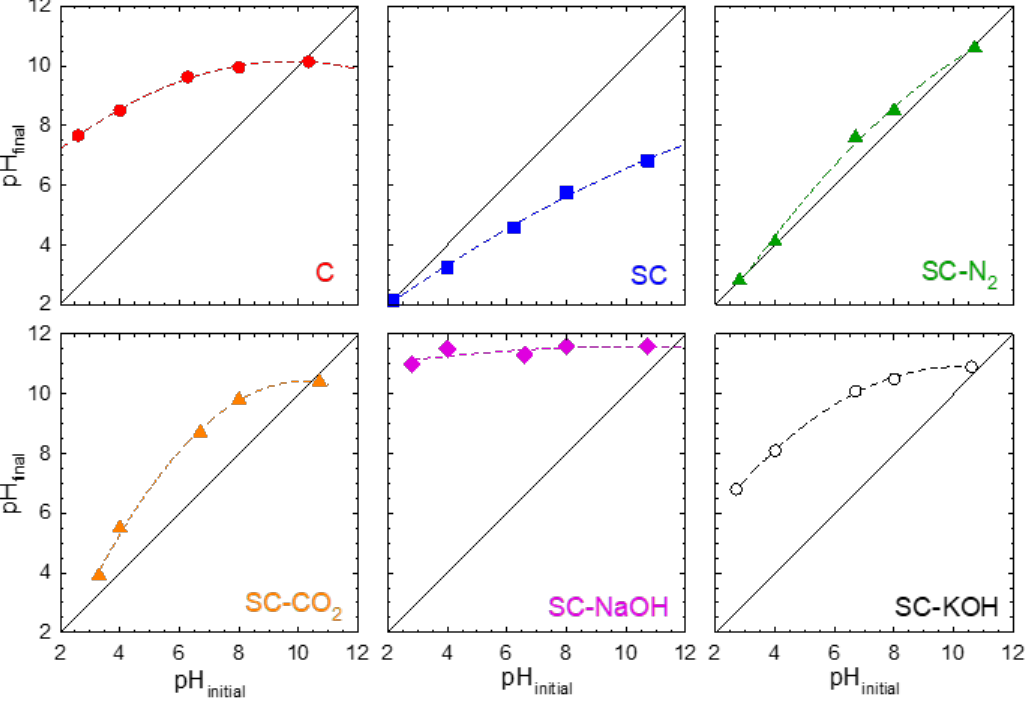
Figure 5. Metal leaching in the char from pyrolysis before and after activation at different pH.